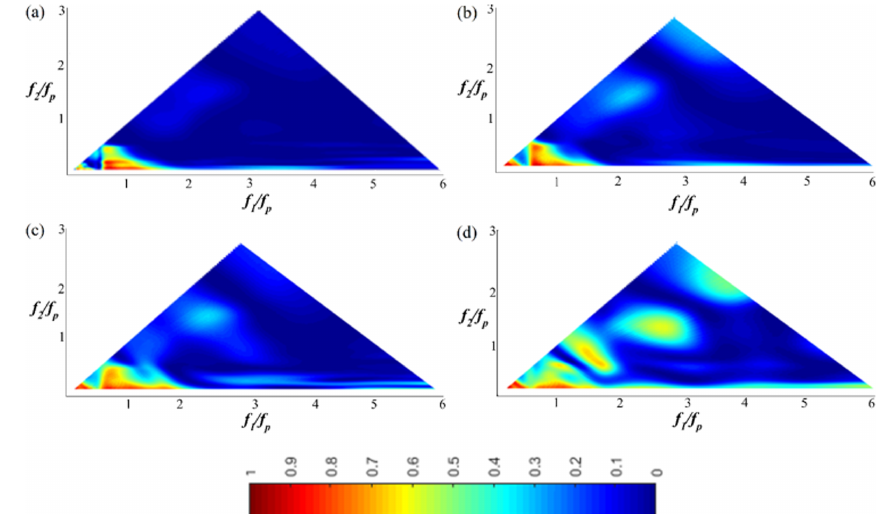
Figure 5. The wavelet-based bicoherence spatial evolution on the flat bottom for a Pierson–Moskowitz wave train (Test 3). (a) x = 4m; (b) x = 5m; (c) x = 8m; (d) x = 9 . 6m.